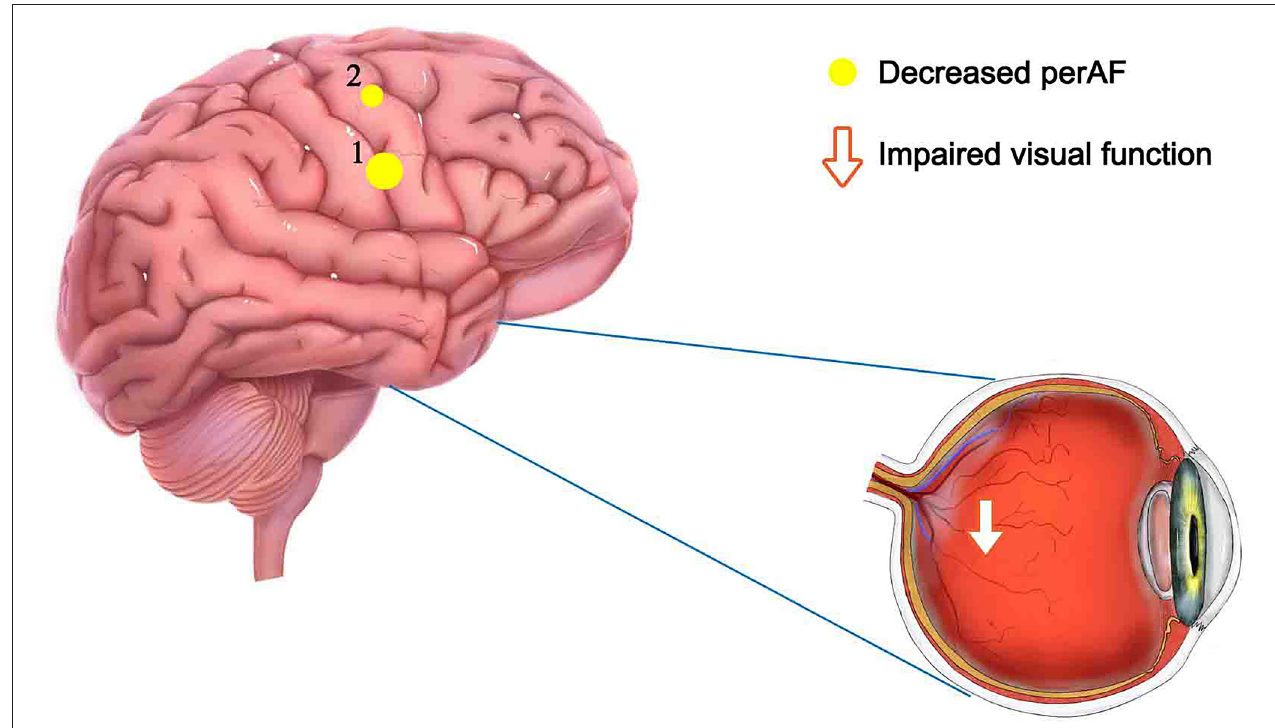
FIGURE 5 | Mean PerAF values for altered brain regions. Compared with HCs, PerAF values in the following regions decreased to varying degrees: 1- right dorsolateral superior frontal gyrus (BA 4, t = − 4.3395), 2-right posterior central gyrus (BA 58, t = − 4.7844). PerAF, percent amplitude of fluctuation; HCs, healthy controls; BA, Broadman